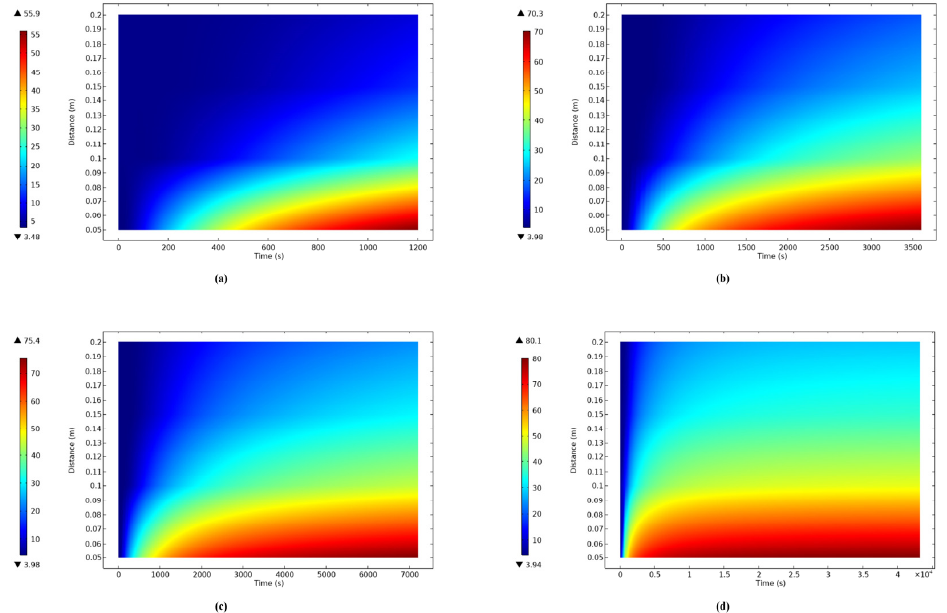
Figure 8. Table of the surface of the probe temperature: ( a ) simulation with heating time of 1200 s; ( b ) simulation with heating time of 60 min; ( c ) simulation with heating time of 120 min; ( d ) simulation with heating time of 12 h.